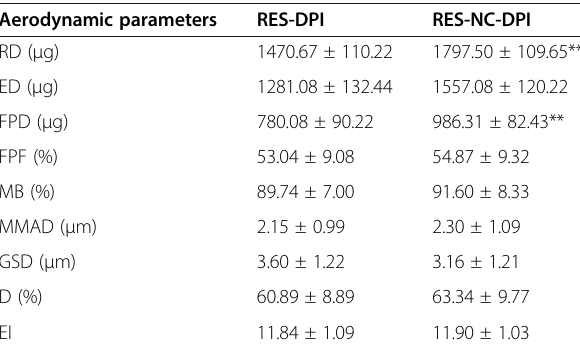
Table 4 Aerodynamic assessment of RES-NC-DPI and RES-DPI at a flow rate of 60 L/min (mean ± SD, n = 3) Aerodynamic